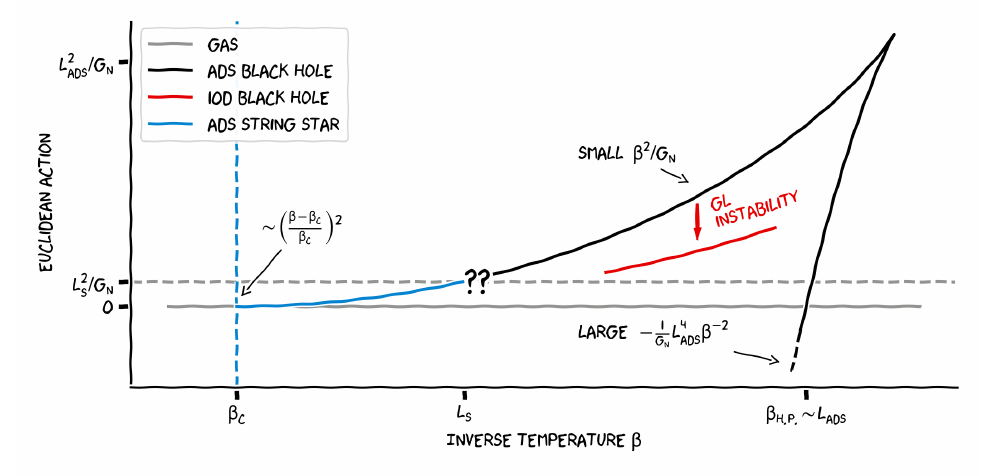
Figure 1 . Schematic phase diagram of the holographic thermal partition function on S d − 1 × S 1 , drawn for d = 3 . β labels the asymptotic length of the S 1 , it is the circumference of the thermal circle at the origin of AdS space in the thermal AdS solution with the same boundary conditions. In black is the d + 1 dimensional AdS black hole. For temperatures l black hole solutions exist (in red). For high enough temperatures small AdS black holes decay into 10 dimensional black holes through the Gregory-Laflamme (GL) instability (see section 6). The AdS string star solution (in blue) exists around the Hagedorn temperature. It reliably joins with the thermal gas phase (in gray) at the AdS Hagedorn temperature β believed to join with the (small) AdS black hole